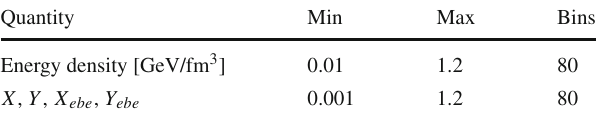
Table 3 Values of the set of constraints that must be satisfied in the system